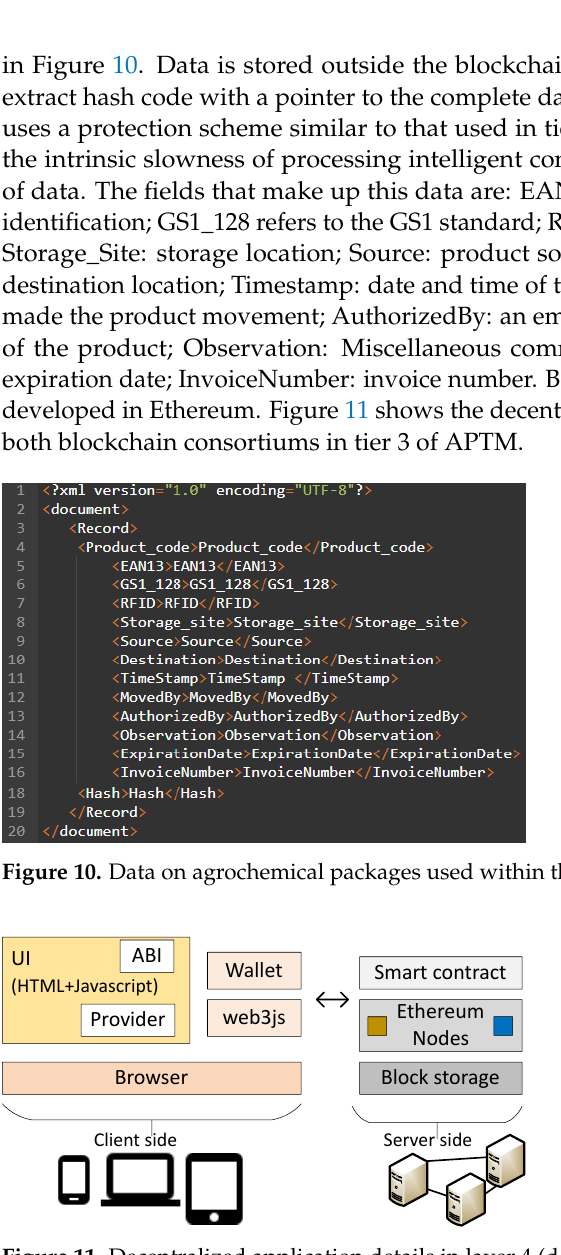
Figure 11. Decentralized application details in layer 4 (dApps on client side and server